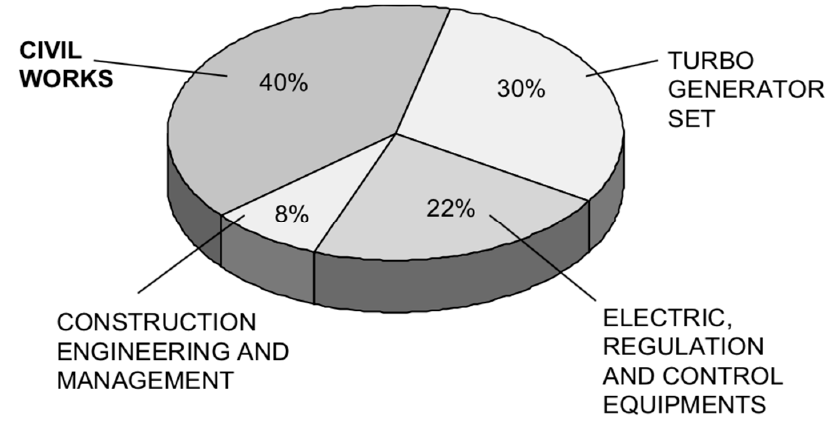
Figure 3. Average distribution of investment on a generic small hydro-power plant. Adapted from [76].